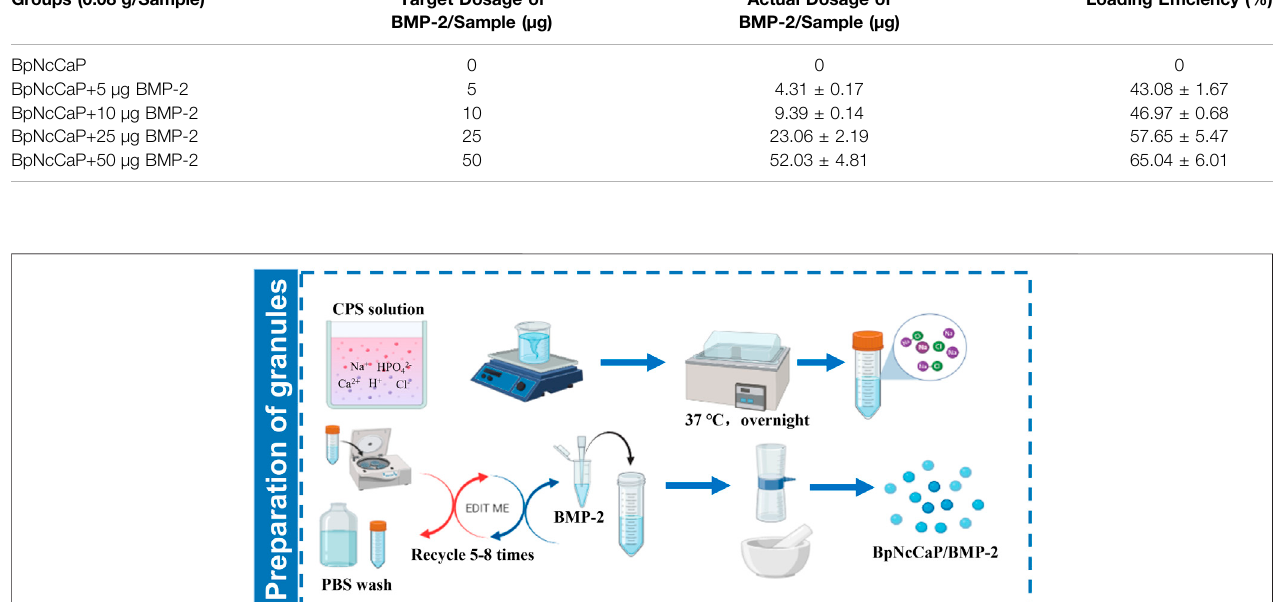
FIGURE 1 | Schematic illustration of preparation of BpNcCaP granules with internally incorporated BMP-2.